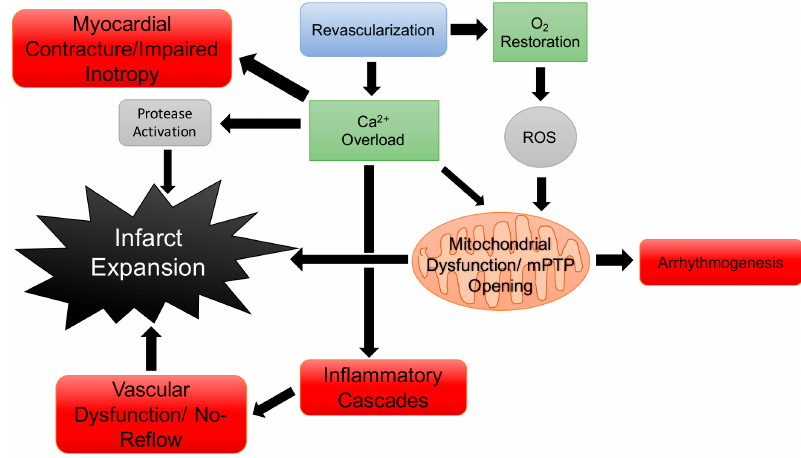
Figure 4. Overview of mechanisms contributing to reperfusion injury. Reperfusion injury results